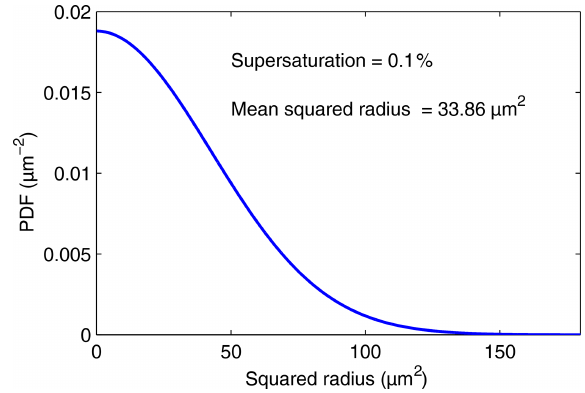
Figure 4. PDF of the droplet squared radius distribution given by Eq. (20) for a supersaturation of 0.1% and h =